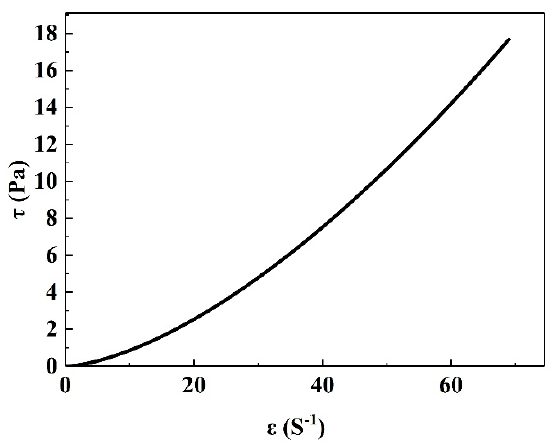
Figure 2. Change of shear stress with shear rate.